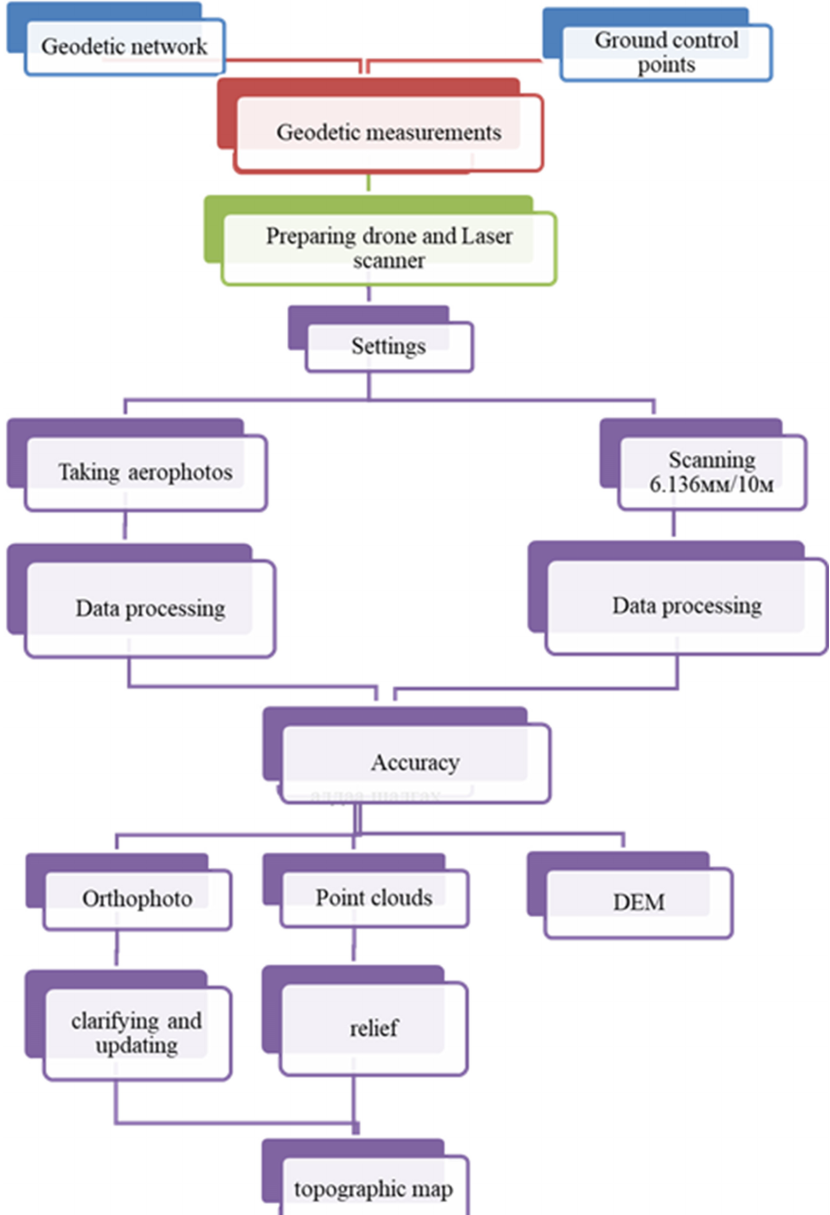
Fig. 4. The general workflow for data acquisition and